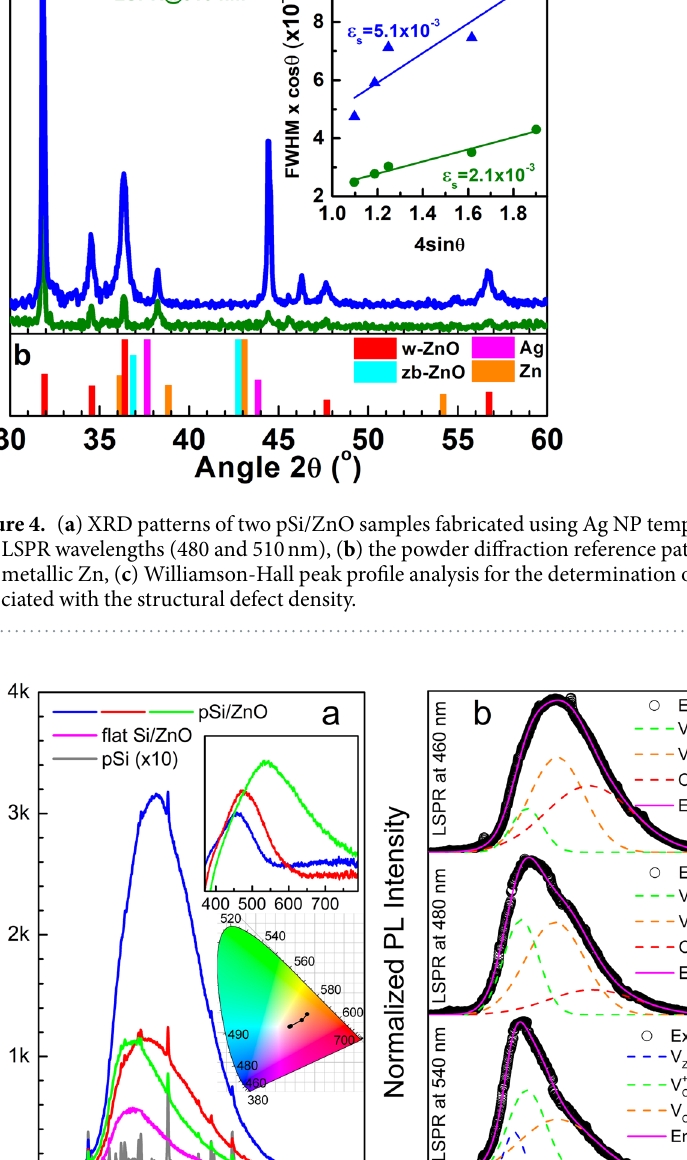
shows the room-temperature PL emission of three samples, fabricated with the use of three different pSi sub- strates (red, green, blue lines). The deposition conditions of the ZnO were the same for all these samples, and only the morphology of the underlying pSi varied. The inset of Fig. 5a depicts the reflectivity spectra of the Ag NPs that were used for the preparation of the corresponding pSi substrates (as shown in Fig. S1 the Ag particles size used